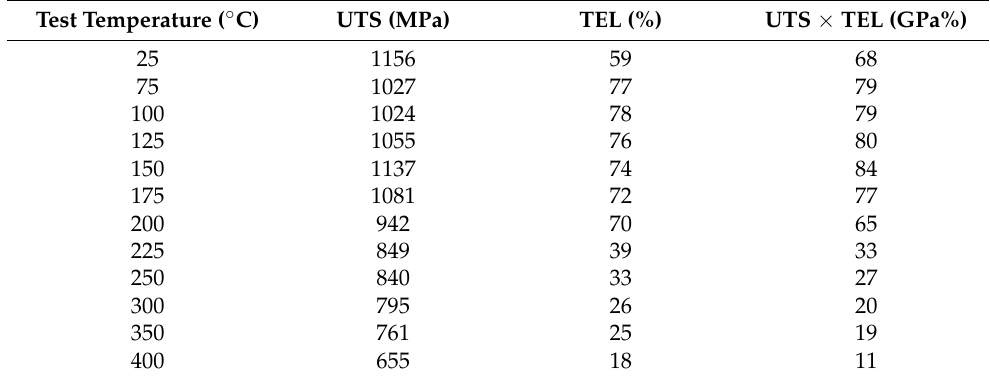
Figure 2. Engineering stress-strain curves obtained by tensile testing at different temperatures, under a constant strain rate of 1 × 10 − 5 s − 1 . Table 1. Ultimate tensile strength (UTS), total elongation (TEL) and UTS × TEL obtained at different test temperatures.